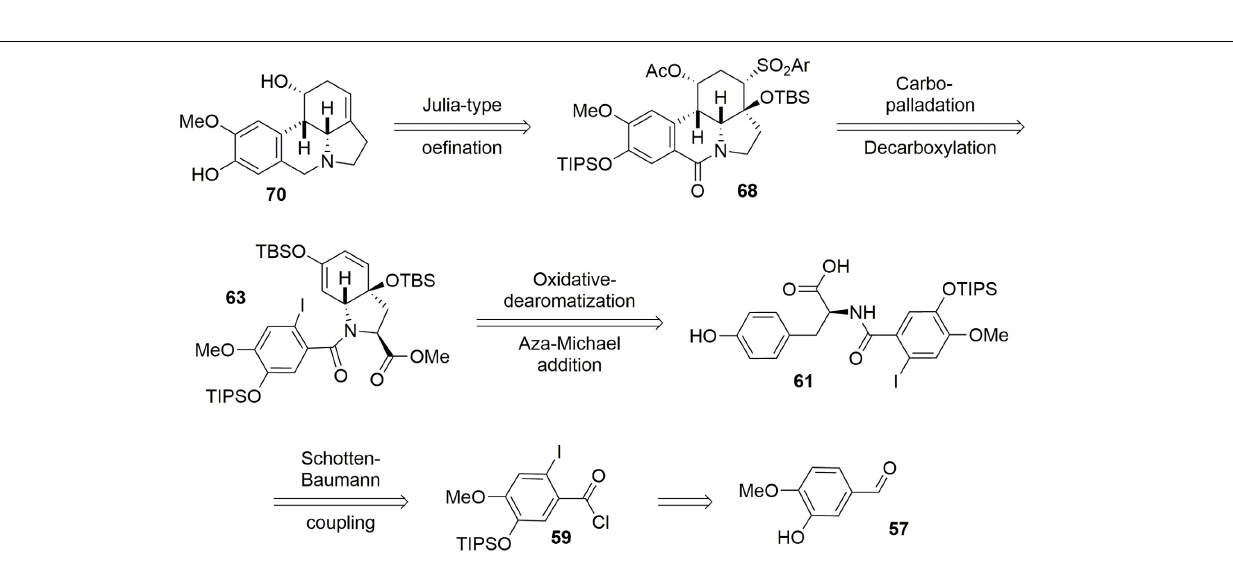
FIGURE 12 | Fortucine